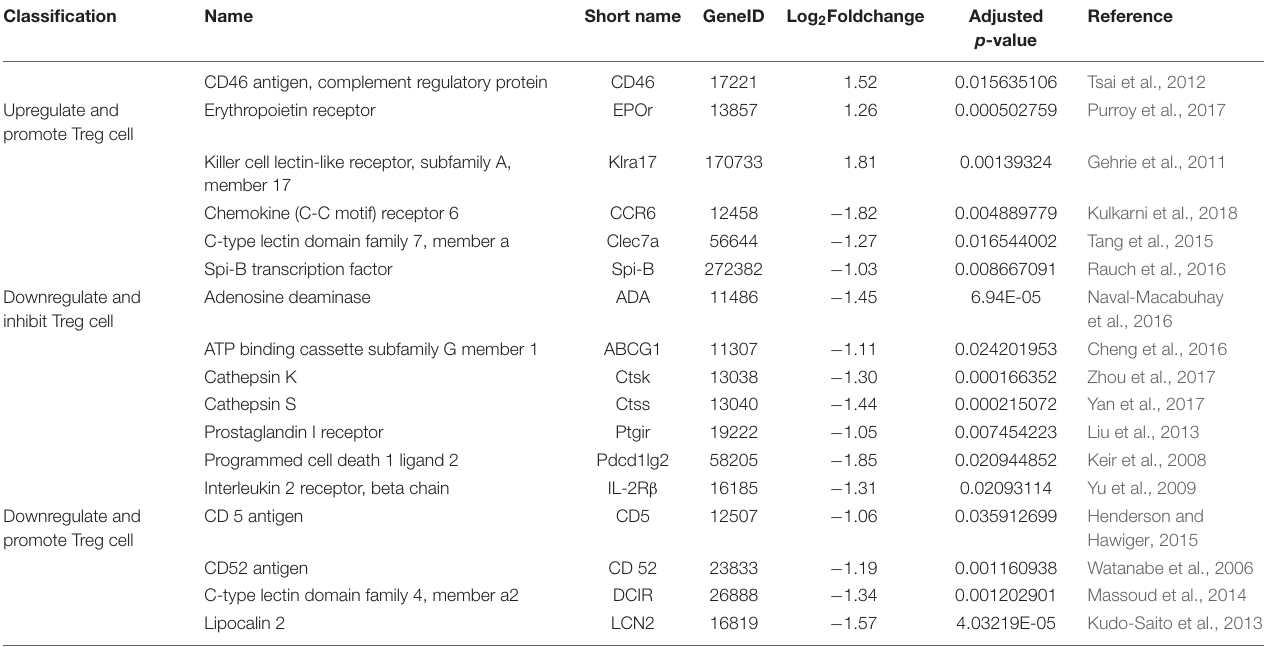
TABLE 1 | Differential expression genes reported to promote or inhibit Treg cell response.